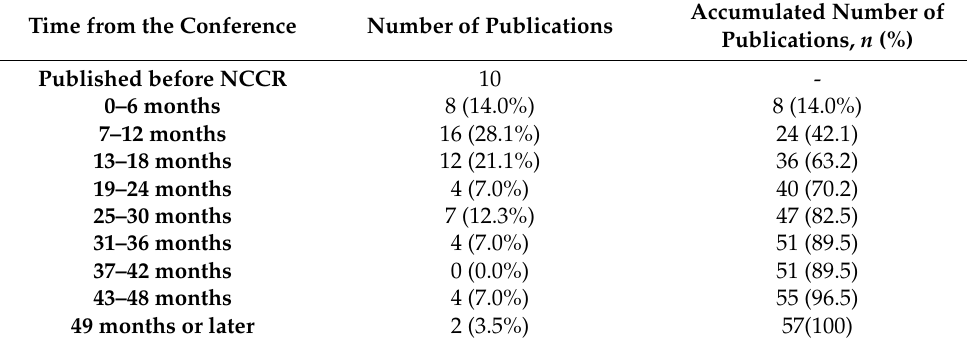
Accumulated Number of Publications, n (%)